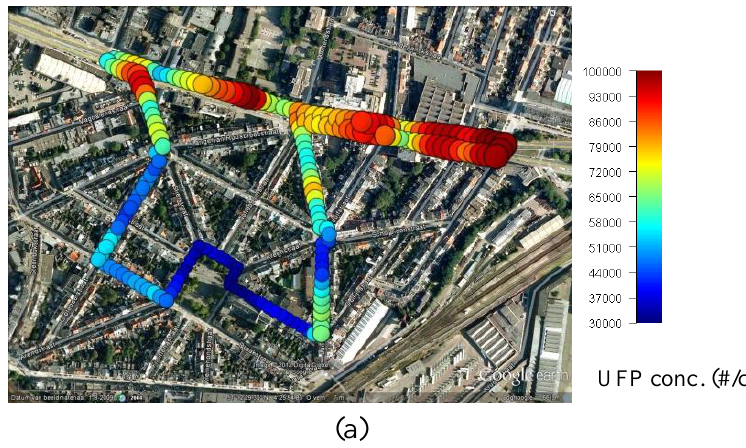
Figure 11. Aggregated maps of mobile UFP ( a ) and BC ( b )